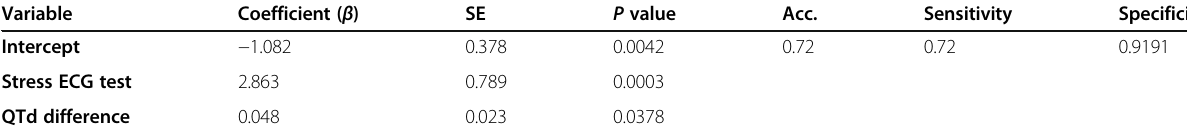
Table 5 Accuracy of stress ECG test to diagnose ischemia when adding the QTd difference Variable